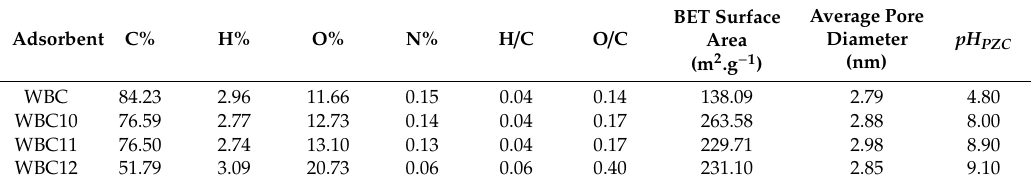
Table 1. Physico-chemical properties of WBC and